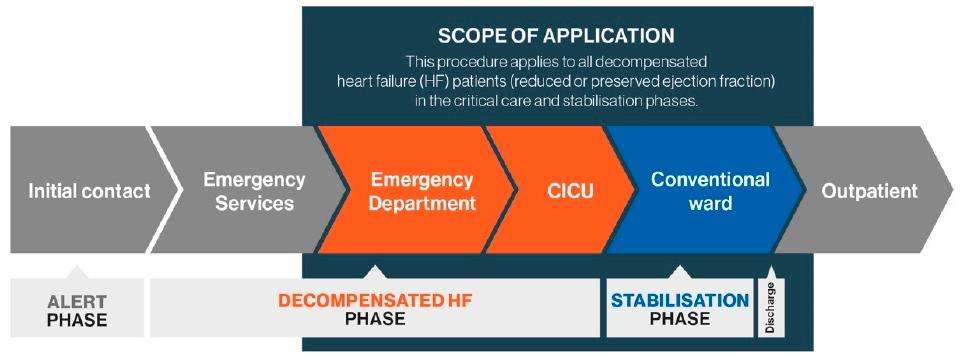
Figure 1. Patient